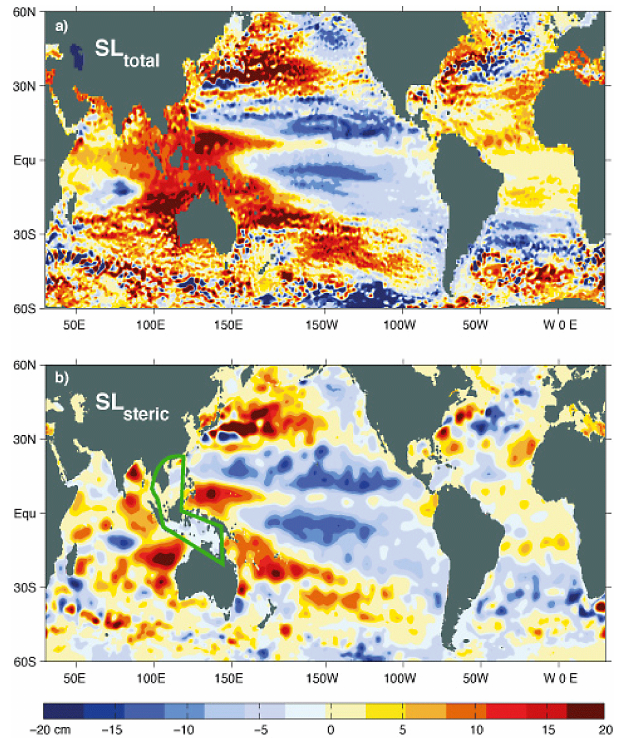
Figure 4. Map of 7-year trends (2005–2011) of (a) total sea level from AVISO and (b) steric sea level (10–1500m) based on the D2CA1S2 re-analysis (see Sect. 2.1). The green bold line in (b) marks the area of the Tropical Asian Archipelago (TAA) with poor hydrographic sampling. Note that land masks are given by the dif- ferent analyses (from the AVISO gridded field analysis in panel (a) , and from the in situ re-analysis in panel (b) , which explains the slight difference in land masks in the two panels.